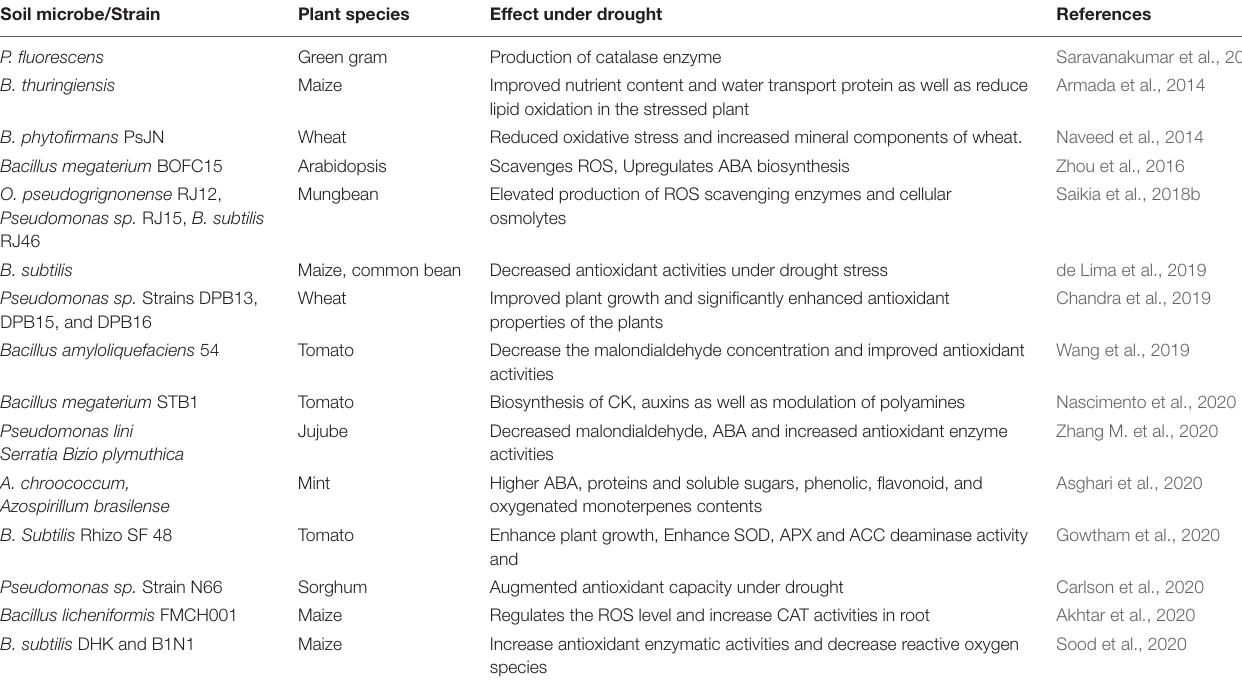
TABLE 6 | Improvement in phytohormone/enzyme production by PGPR under drought stress.